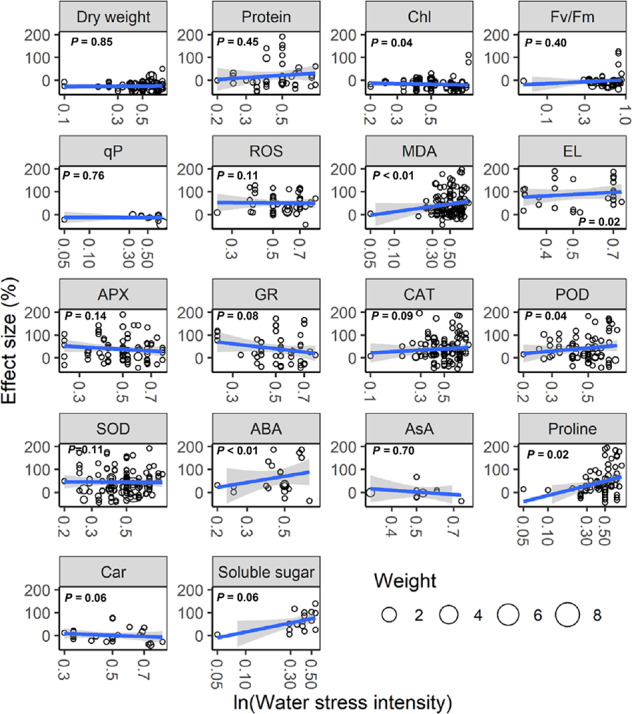
Responses of plant physiological indices to water stress intensity. Linear regressions (blue lines) and their 95% confidence intervals (shaded areas) and corresponding levels of significances (P values) are presented. Circle sizes are proportional to the sampling variances. See 
Figure 1
 for abbreviations.